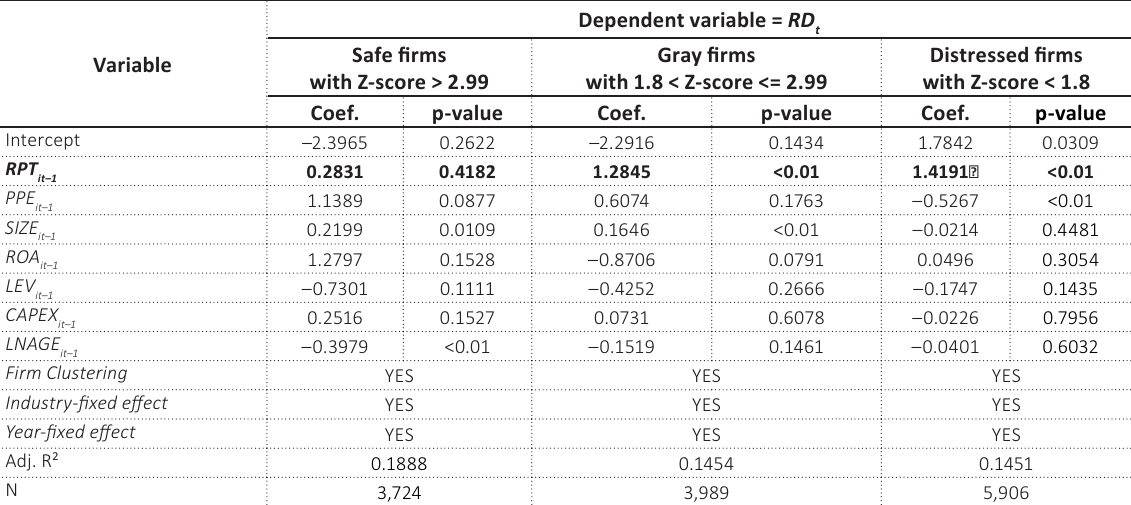
Table 4. The effect of RPTs on a firm’s R&D investments based on the firm’s financial health Panel A: Subsample analysis based on Altman’s (1968)